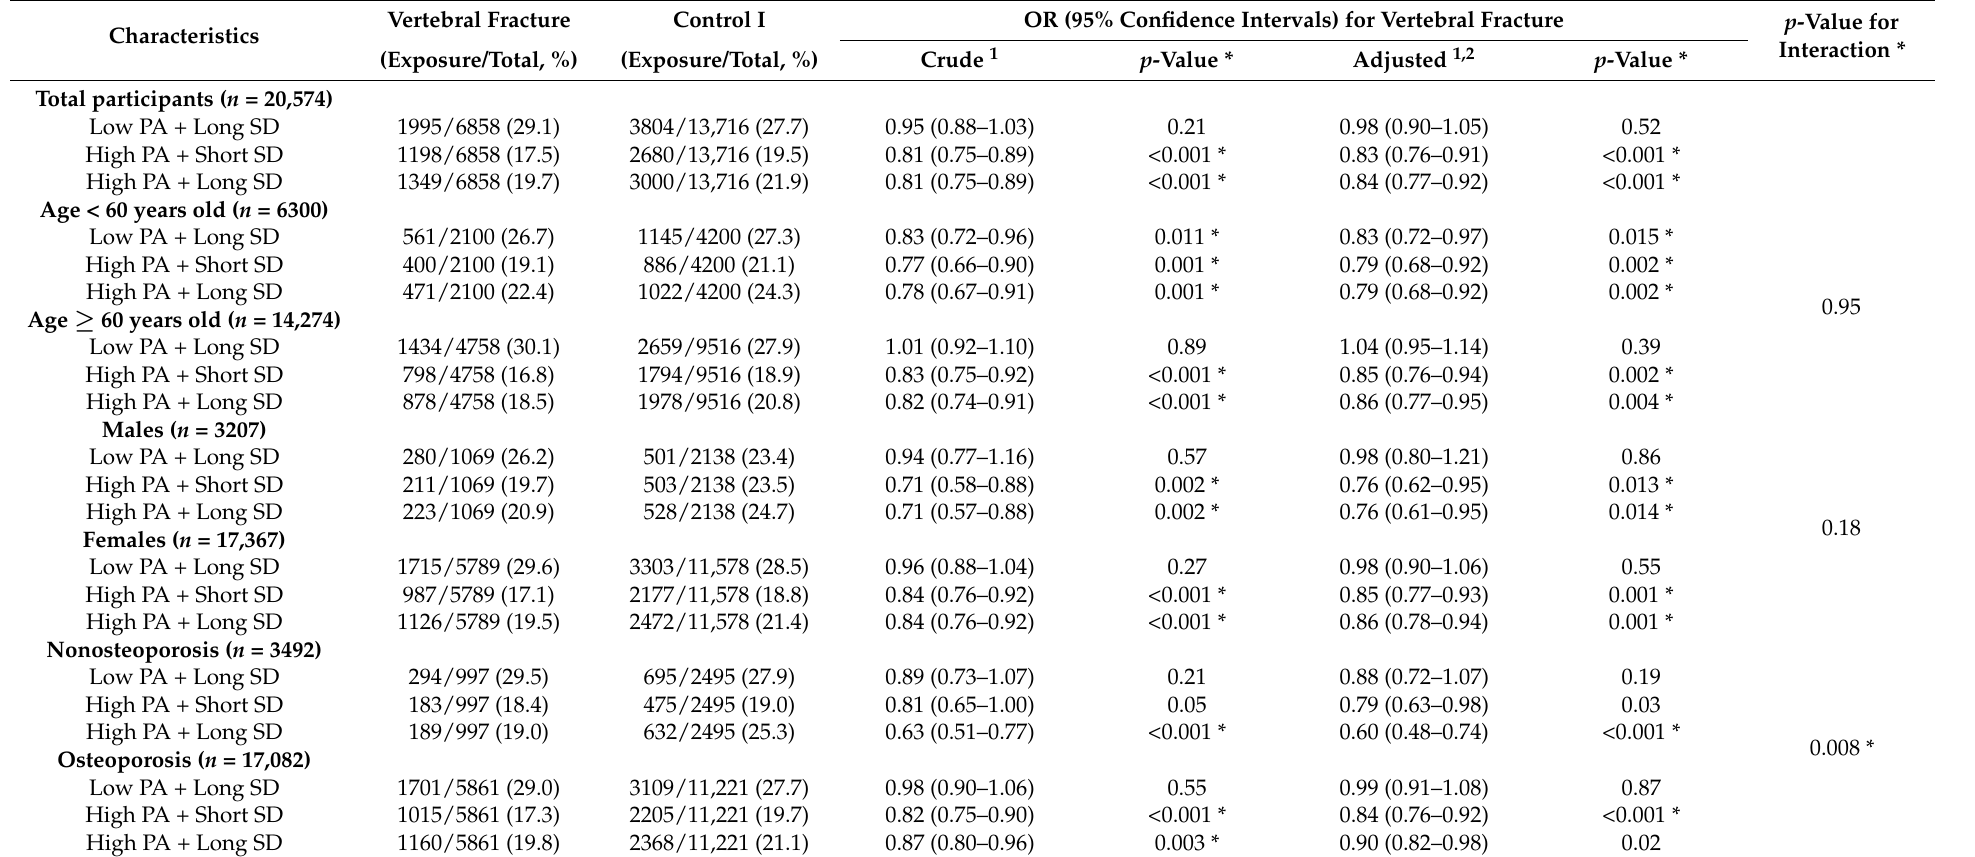
Table 2. Odds ratios (95% confidence intervals) of physical activity and sunshine duration for vertebral fracture with subgroup analyses according to age, sex, and osteoporosis history (reference: Low PA + Short